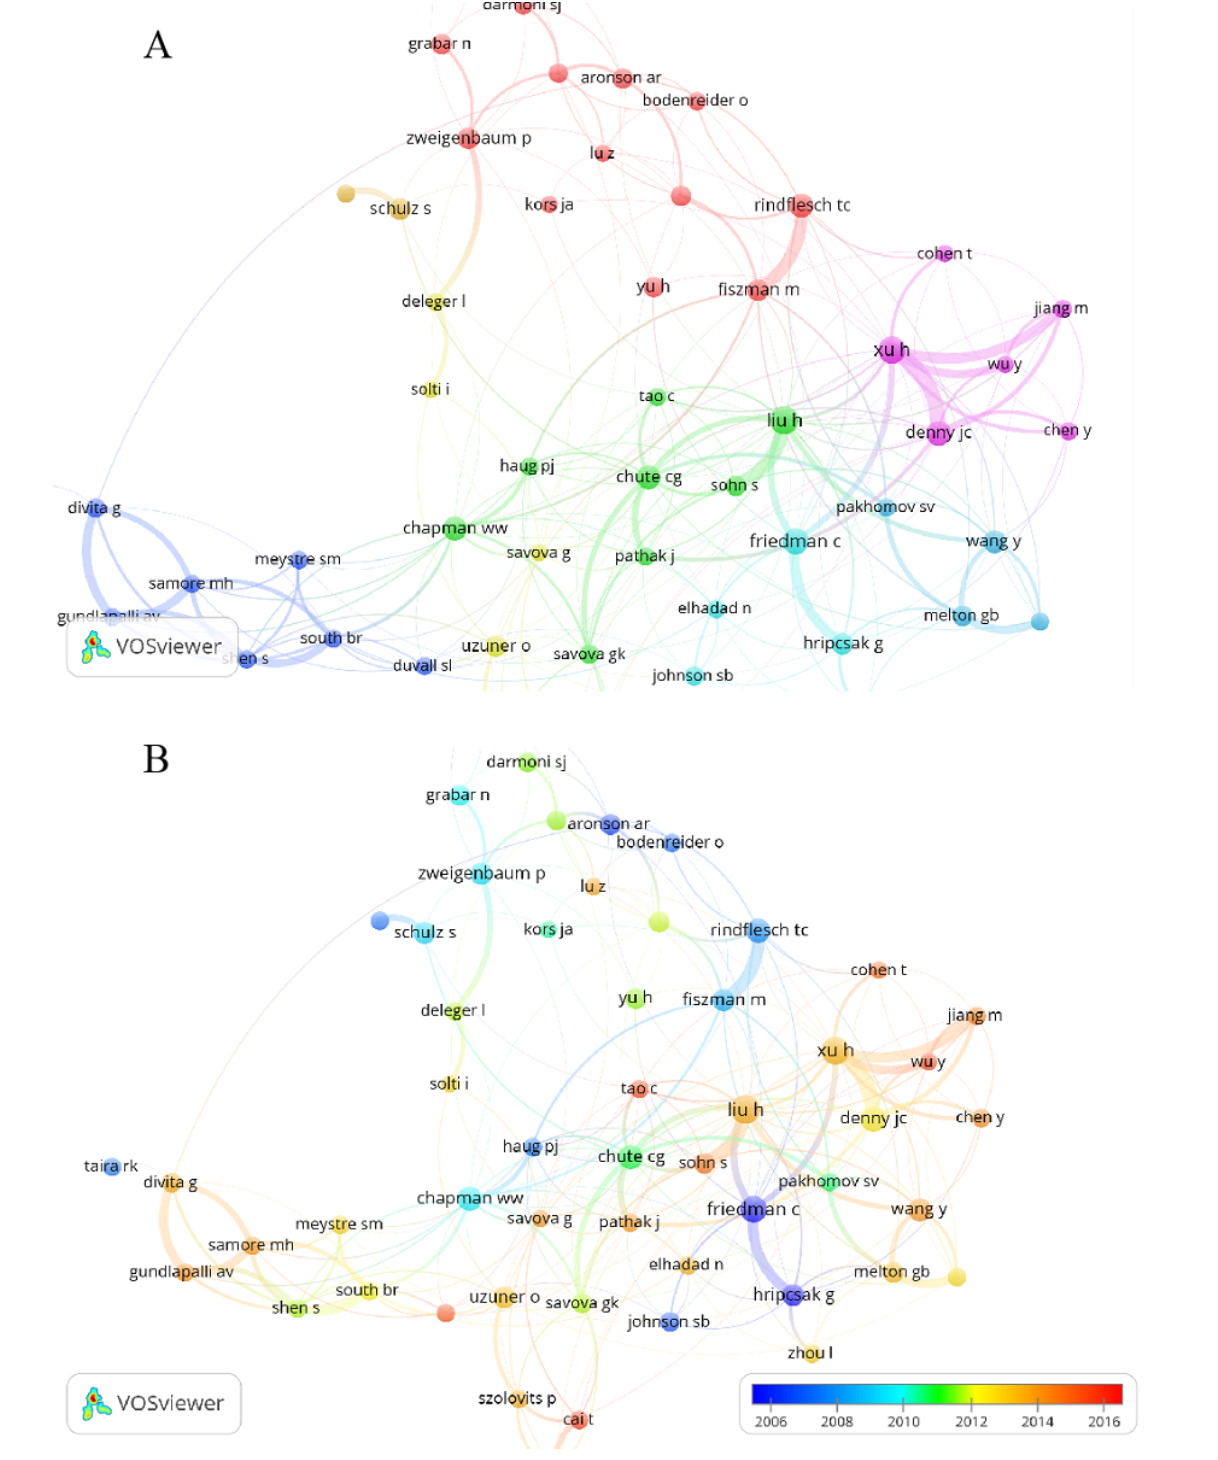
Figure 4. (A) Network visualization of author co-occurrences analyzed using VOSviewer. A circle represents an author, the size of the circle represents the importance, and the thickness of the link connecting the circles represents the relatedness of the connections. Circles with the same color belong to the same cluster. (B) Overlay visualization generated in VOSviewer (Centre for Science and Technology Studies, Leiden University). A color closer to blue represents an earlier time and closer to red represents a time closer to 2018 (note: refer to Multimedia Appendix 1 for details on the two diagrams and related